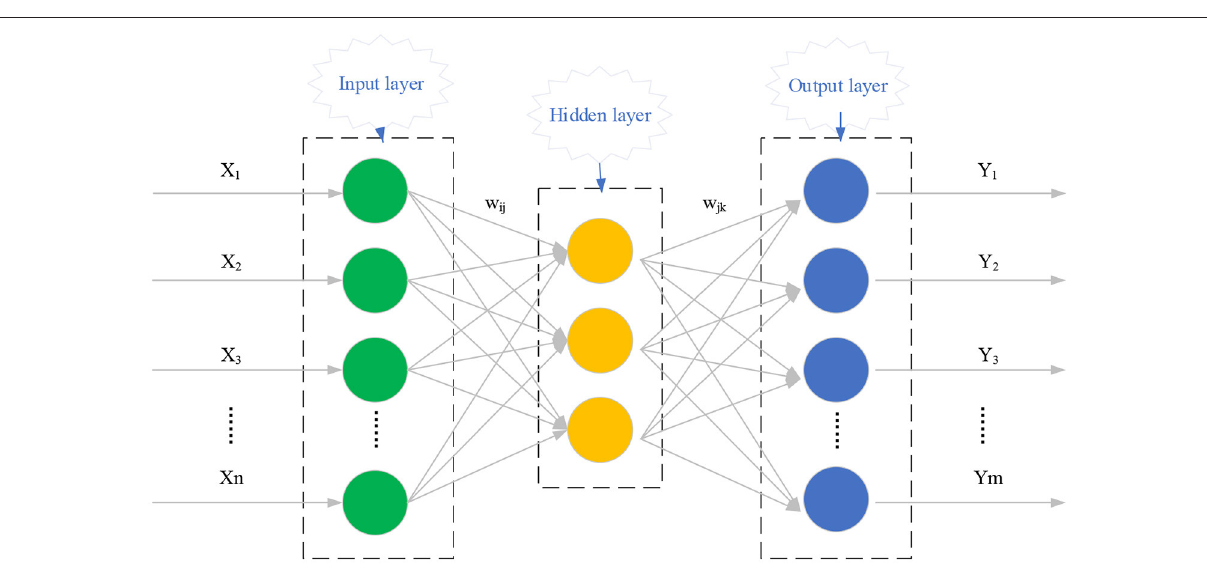
FIGURE 3 | Three-layer ANN